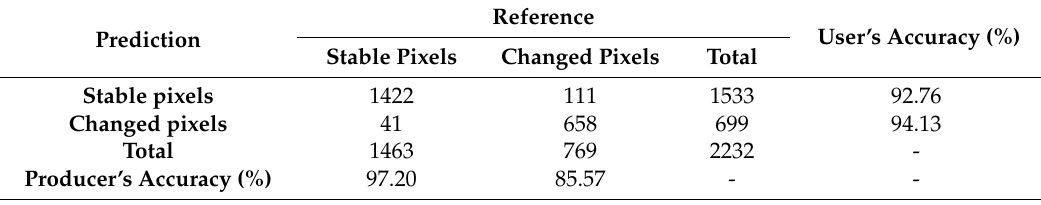
Table 2. Change detection assessment of HSMM-based post-classification algorithm.